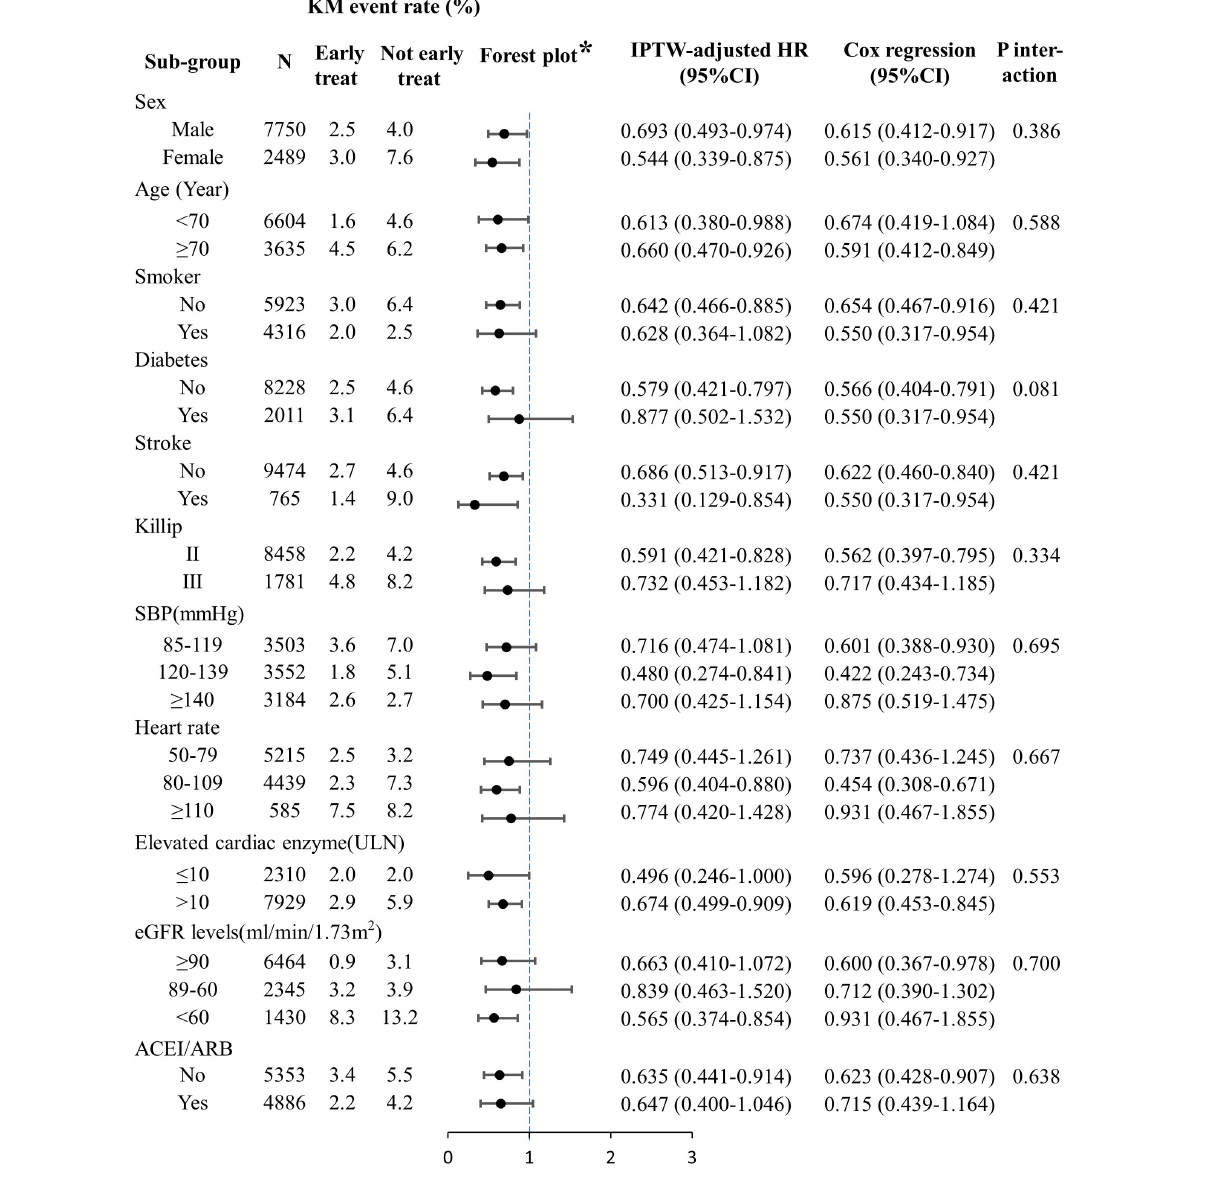
FIGURE 3 | Subgroup analyses of the effects of early oral β -blocker therapy on in-hospital outcomes. ACEI, angiotensin-converting enzyme inhibitor; ARB, angiotensin receptor blocker; eGFR, estimated glomerular filtration rate; IPTW, inverse-probability-of-treatment weighting; PCI, percutaneous coronary intervention; SBP, systolic blood pressure; ULN, upper limit of normal. *IPTW analysis